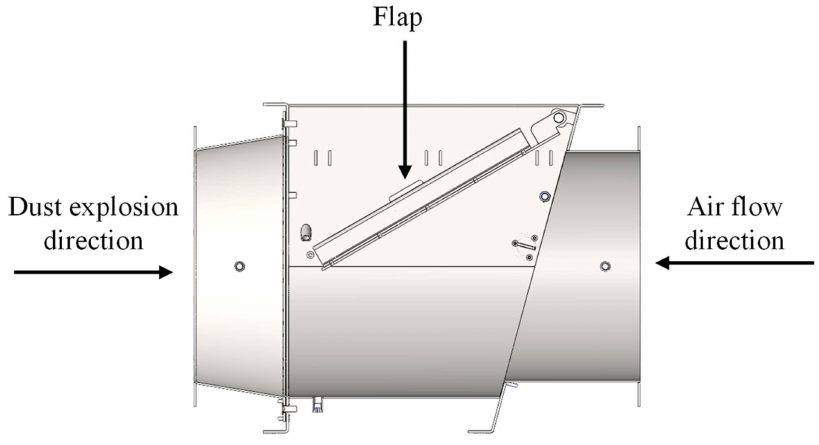
Figure 1. Flap valve